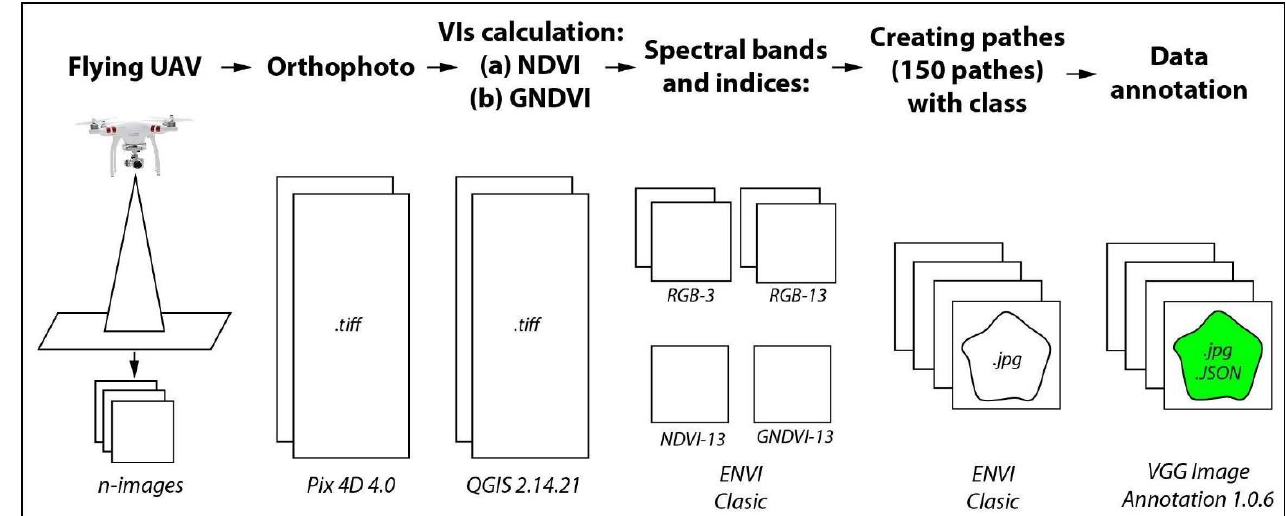
Figure 4. The process of preparing the images of OTCS-dataset.